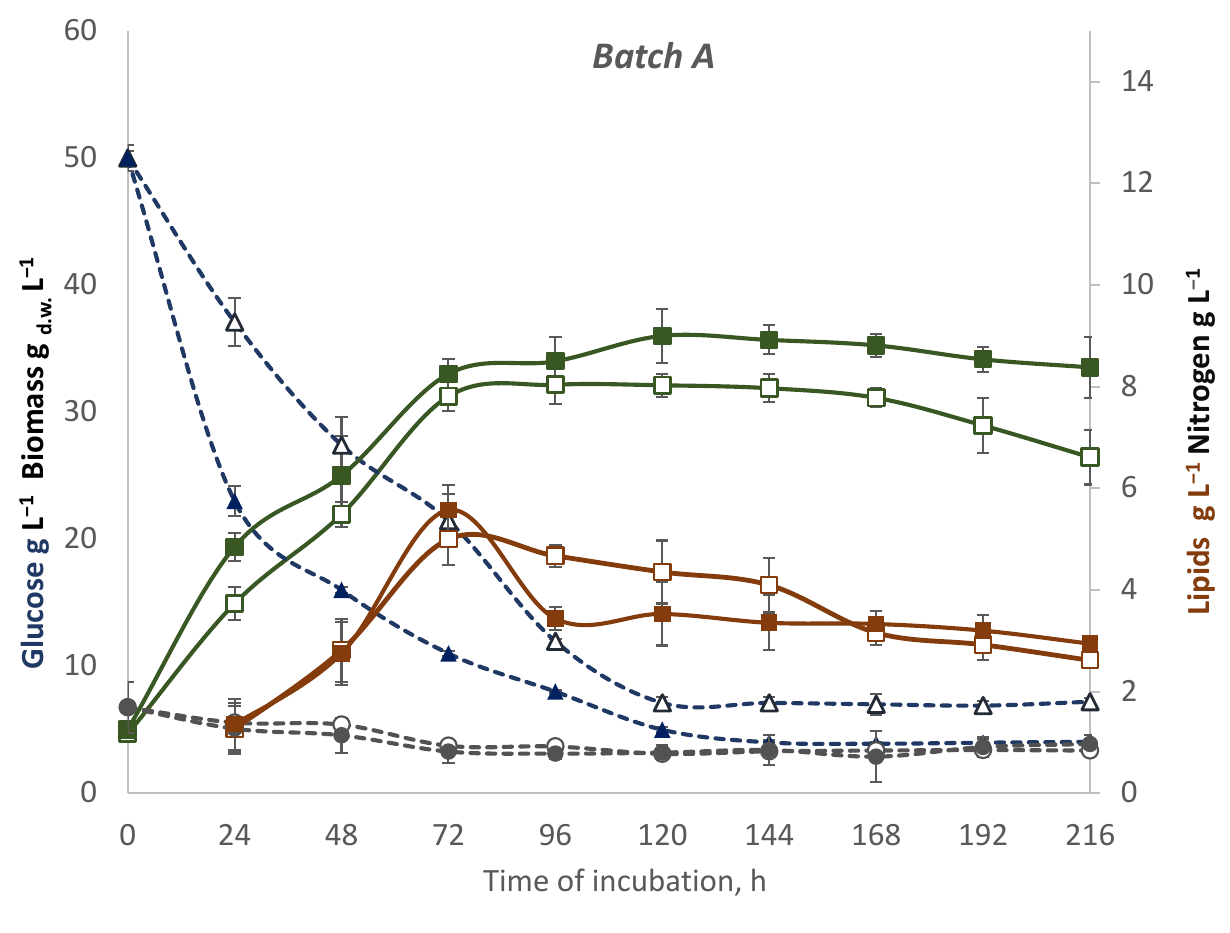
Figure 1. The timecourse of a batch A culture of R. glutinis var . rubescens in DPW and glucose medium containing initial concentrations of glucose 5% at two temperatures: 28 °C (filled tags) and 20 °C (empty tags). Kinetics of substrates: glucose — blue dotted line, nitrogen — grey dotted line, biomass — green line (where d.w. — dry weight), lipids — brown line. Values represent the average of duplicate experiments.